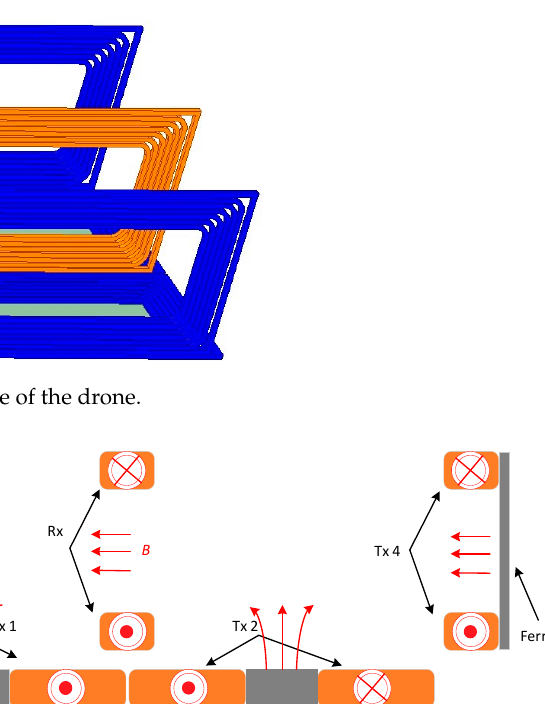
Figure 2. Concave coupling structure of the drone.